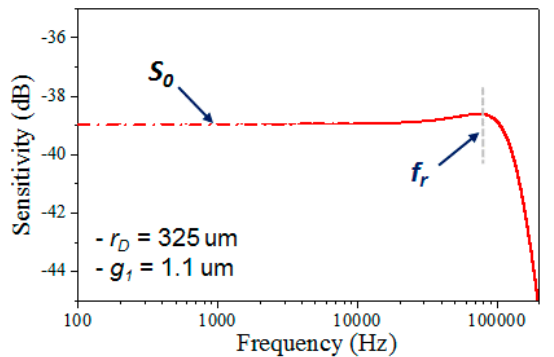
Figure 5. Modelled open-circuit sensitivity ( S o ) as a function of frequency and the resonance frequency ( f r ) at the given bias condition for the capacitive-type MEMS acoustic